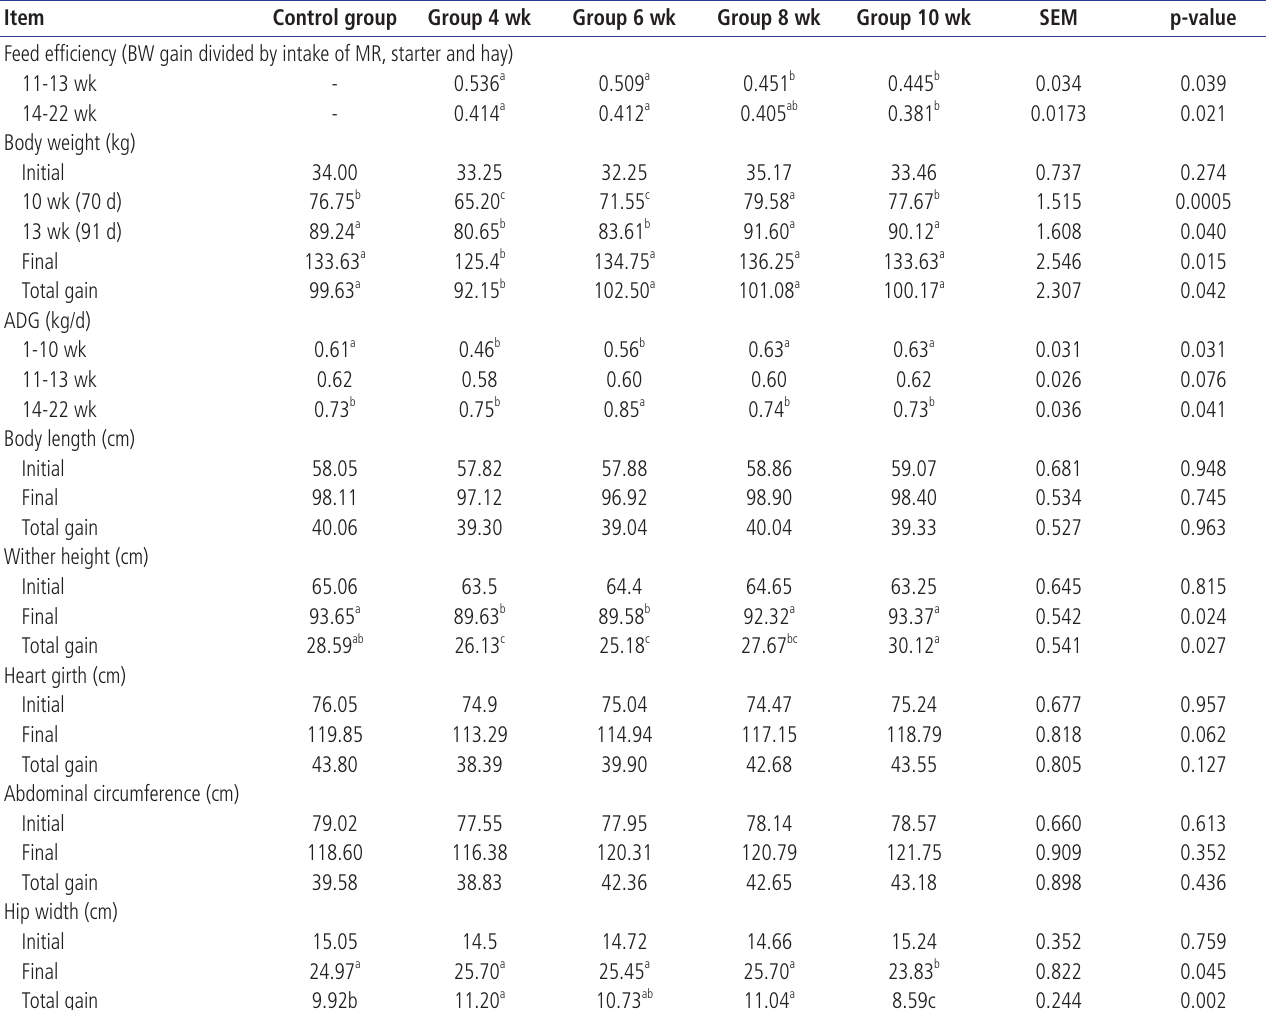
Table 2. Effect of weaning age on growth performance and body size of calves Item Control group Feed efficiency (BW gain divided by intake of MR, starter and